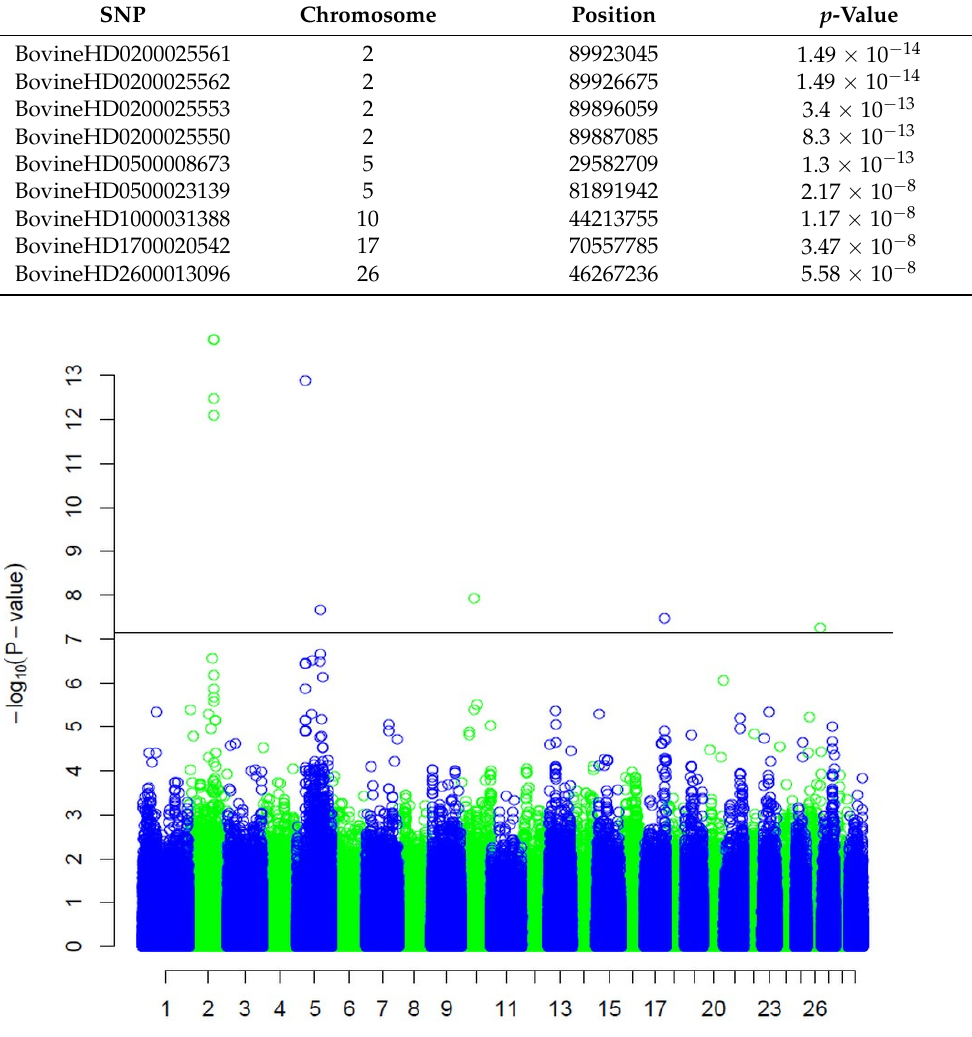
Table 2. SNPs associated with carcass depth, determined by GWAS analysis.